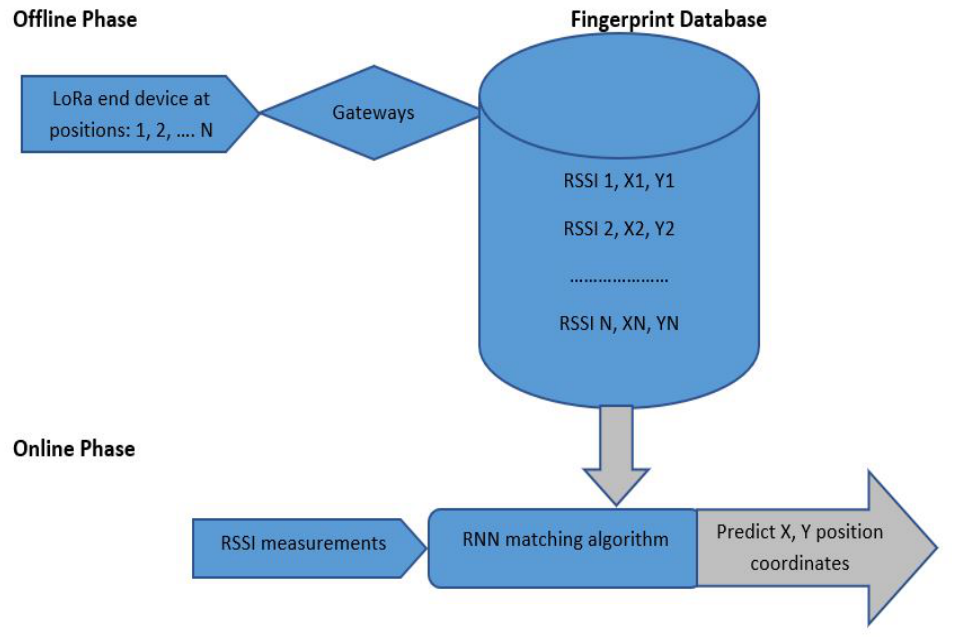
Figure 3. RNN based RSSI fingerprint localization